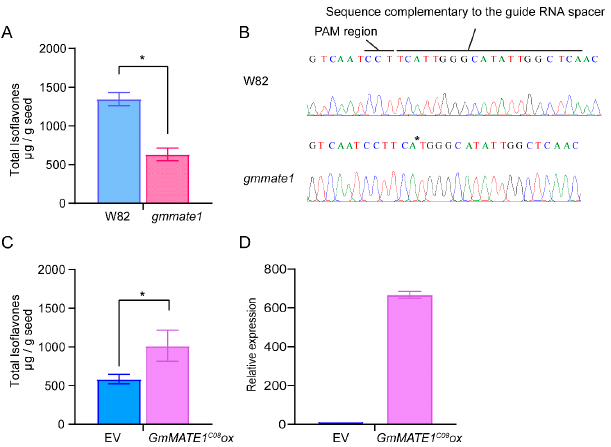
Figure 5. GmMATE1 is responsible for determining seed isoflavone contents. ( A ) The total isoflavone contents in the CRISPR/Cas9-edited gmmate1 mutant was significantly lower than those in its wild-type, W82. Values shown were the means of at least three independently collected batches of seeds ± SEM. Significant differences were determined by Mann-Whitney test. *, p < 0.05. ( B ) The mutation site in the GmMATE1 C08 gene, with the single-nucleotide deletion marked with an asterisk. ( C ) The levels of isoflavones in the transgenic soybean overexpressing GmMATE1 C08 were significantly higher than those in the empty vector control, both in the W82 background. Values shown were the means of four independently collected batches of seeds ± SEM. Significant differences were determined by Mann-Whitney test. *, p < 0.05. ( D ) Relative expression levels of GmMATE1 in the GmMATE1 C08 - overexpressor and the empty vector control in the W82 background. The expression levels were normalized to the reference gene, VPS , using the 2 −ΔΔ Ct method.